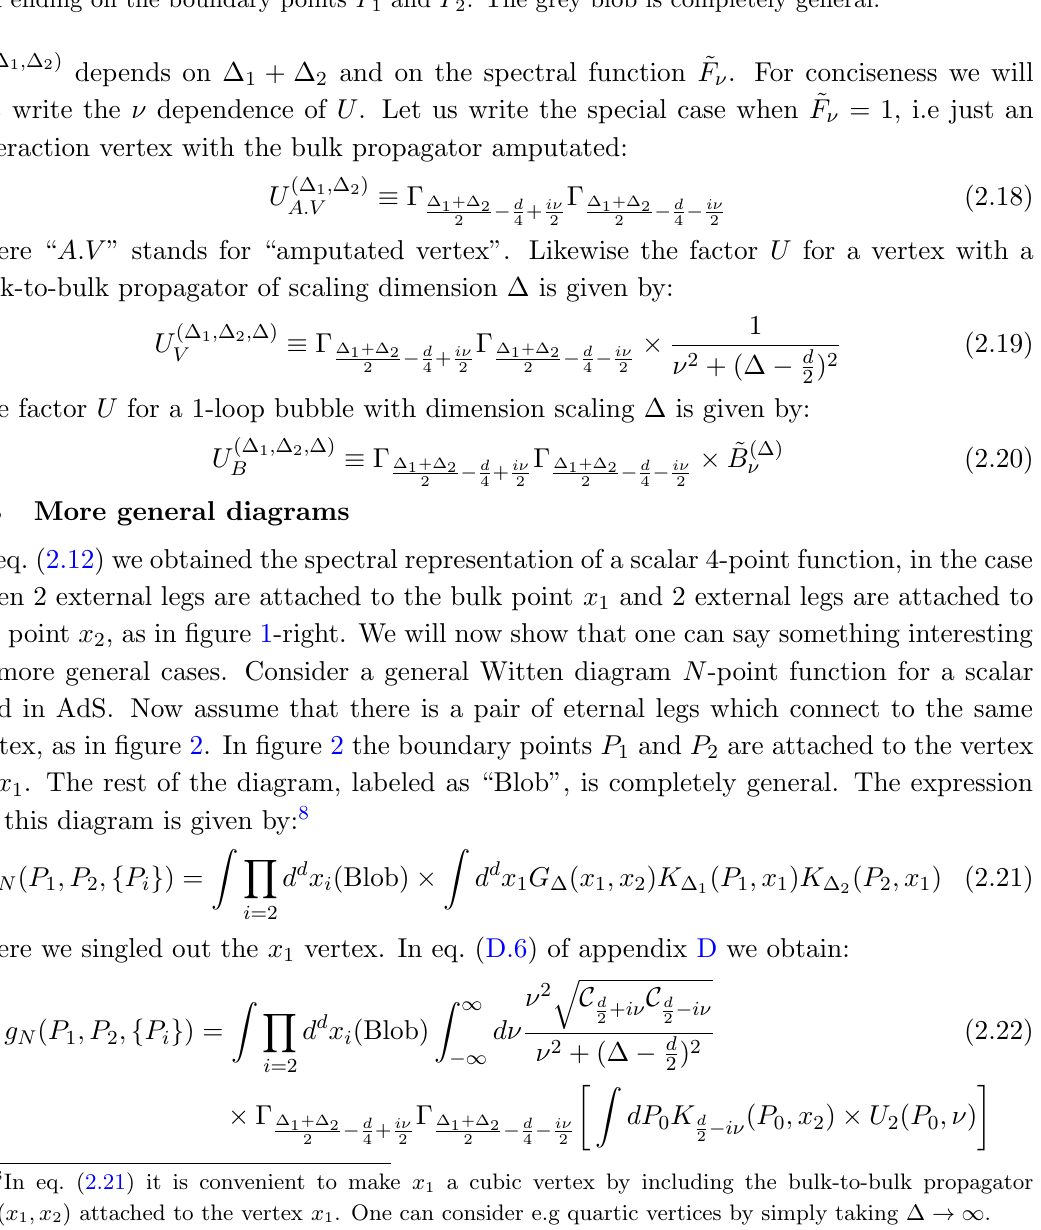
Figure 2 . An N -point function with a pair of external lines originating from the same vertex x 1 , and ending on the boundary points P 1 and P 2 . The grey blob is completely